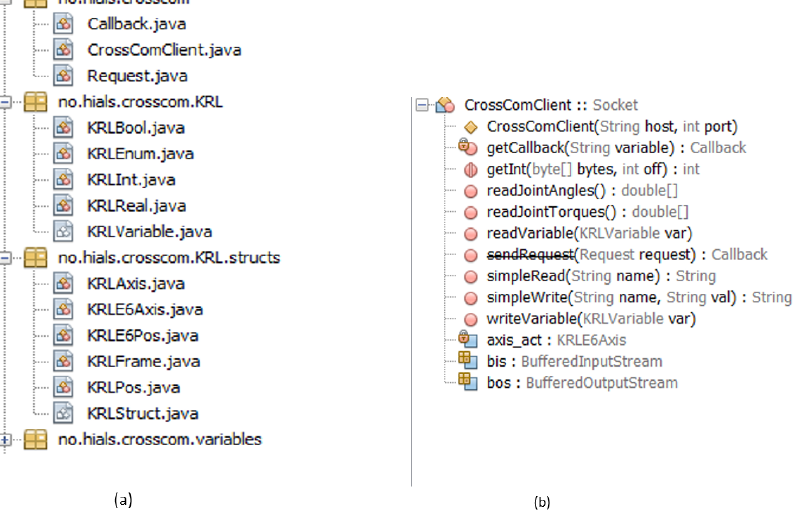
Figure 7. ( a ). The API architecture of JOpenShowVar; ( b ). The API architecture of CrossComClient. KRL and KRL.structs are classes that represent actual variables from different data types in the KRL. This class takes in a string name that represents the exact name of the global variable defined in the